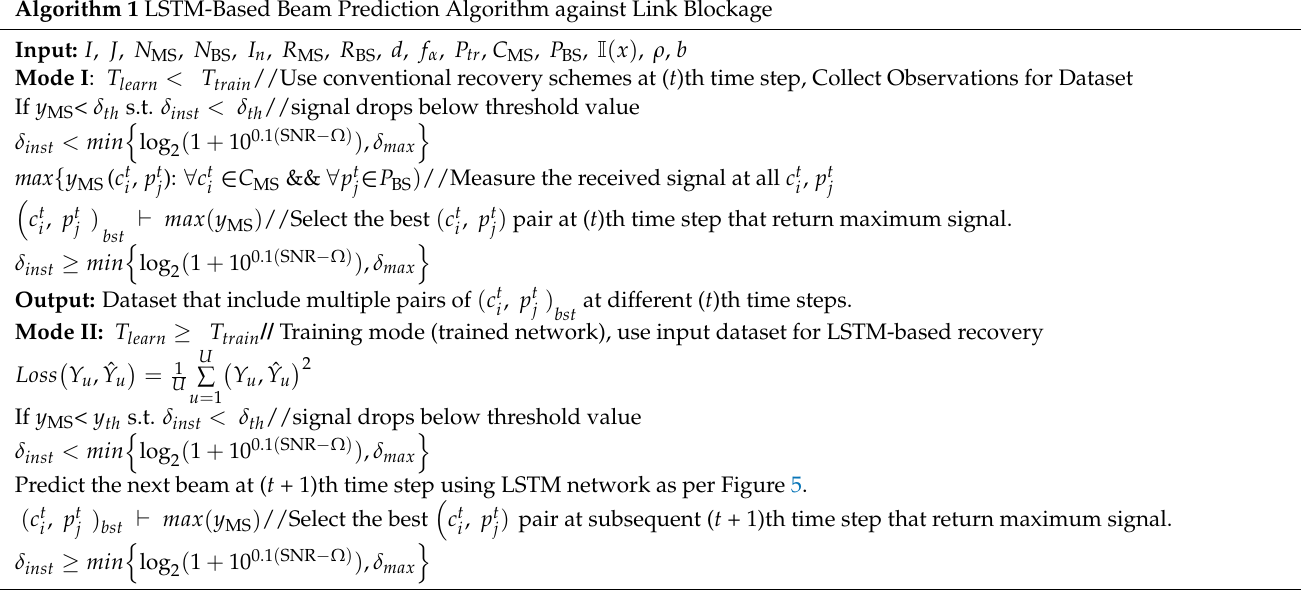
Algorithm 1 LSTM-Based Beam Prediction Algorithm against Link